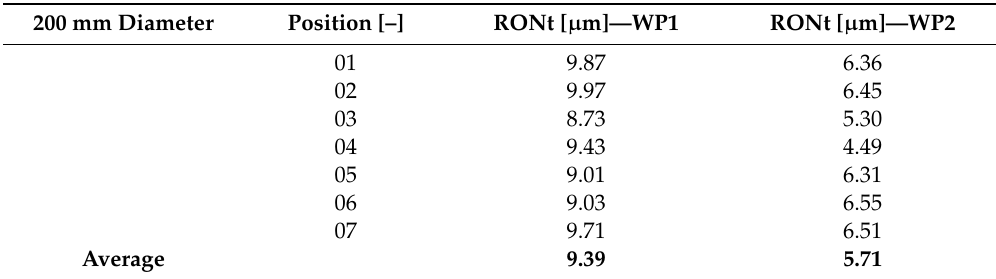
Table 12. RONt results [ µ m]—200 mm diameter.